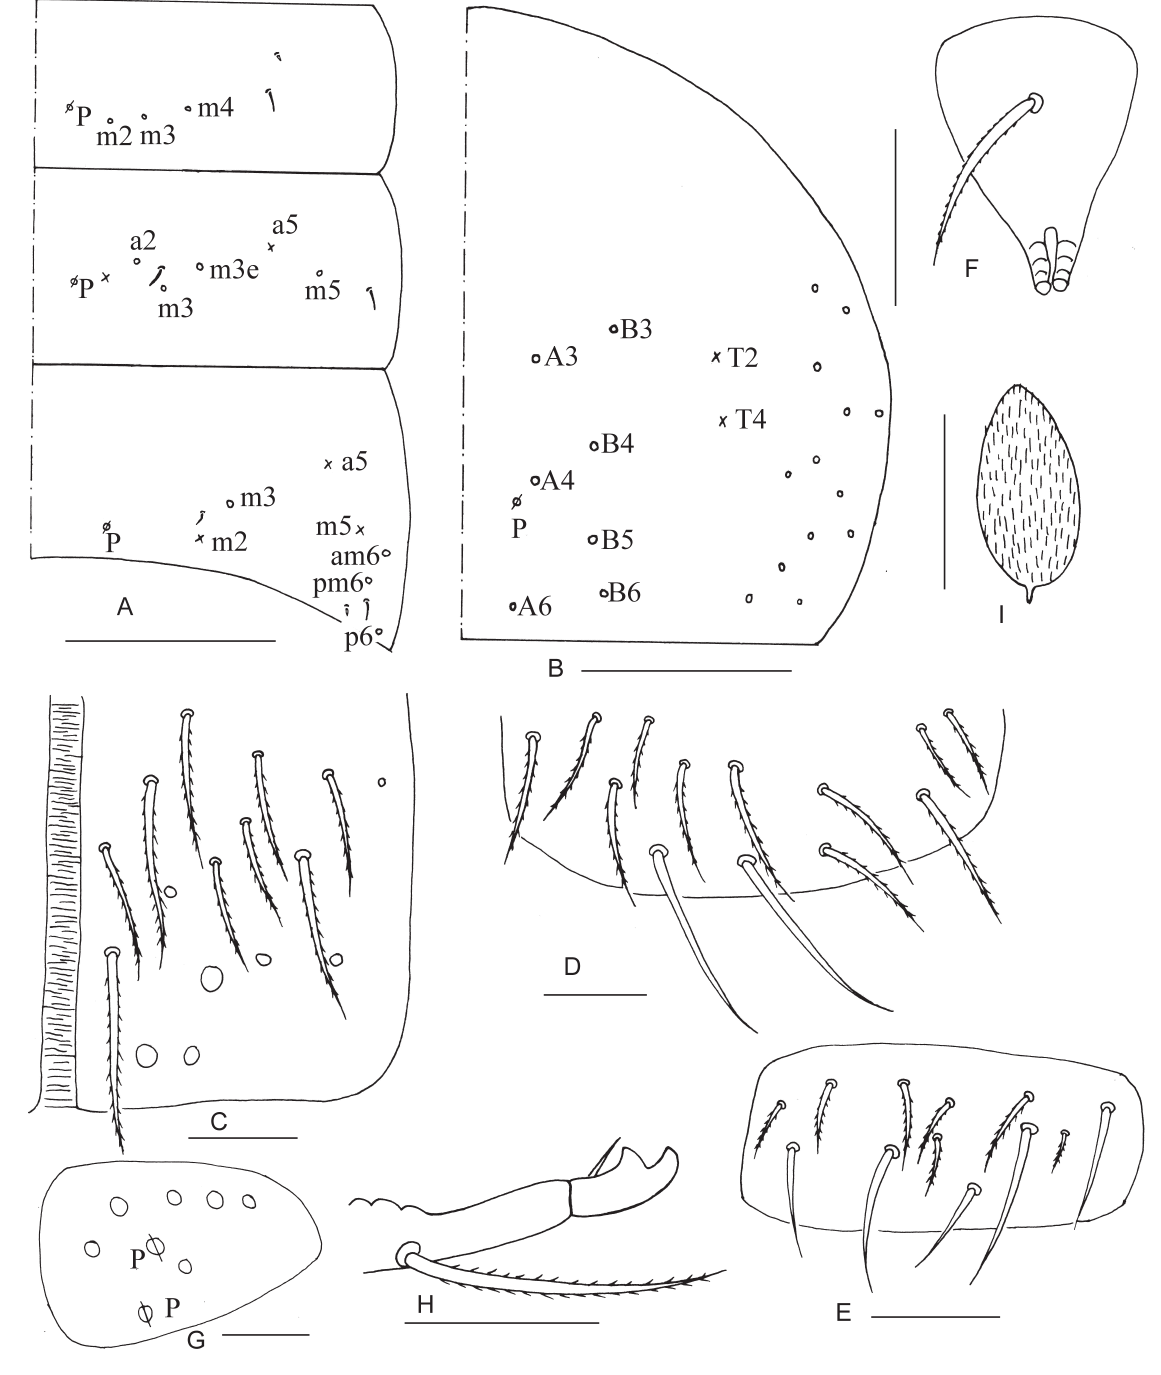
Fig. 10. Willowsia tanae sp. nov. A . Chaetotaxy of Abd. I−III. B . Chaetotaxy of Abd. IV. C . Anterior face of ventral tube. D . Posterior face of ventral tube apically. E . Lateral flap of ventral tube. F . Tenaculun. G . Manubrial plaque. H . Distal part of dens and mucro. I . Scale. Scale bars: A–B = 100 μm; C−I = 20